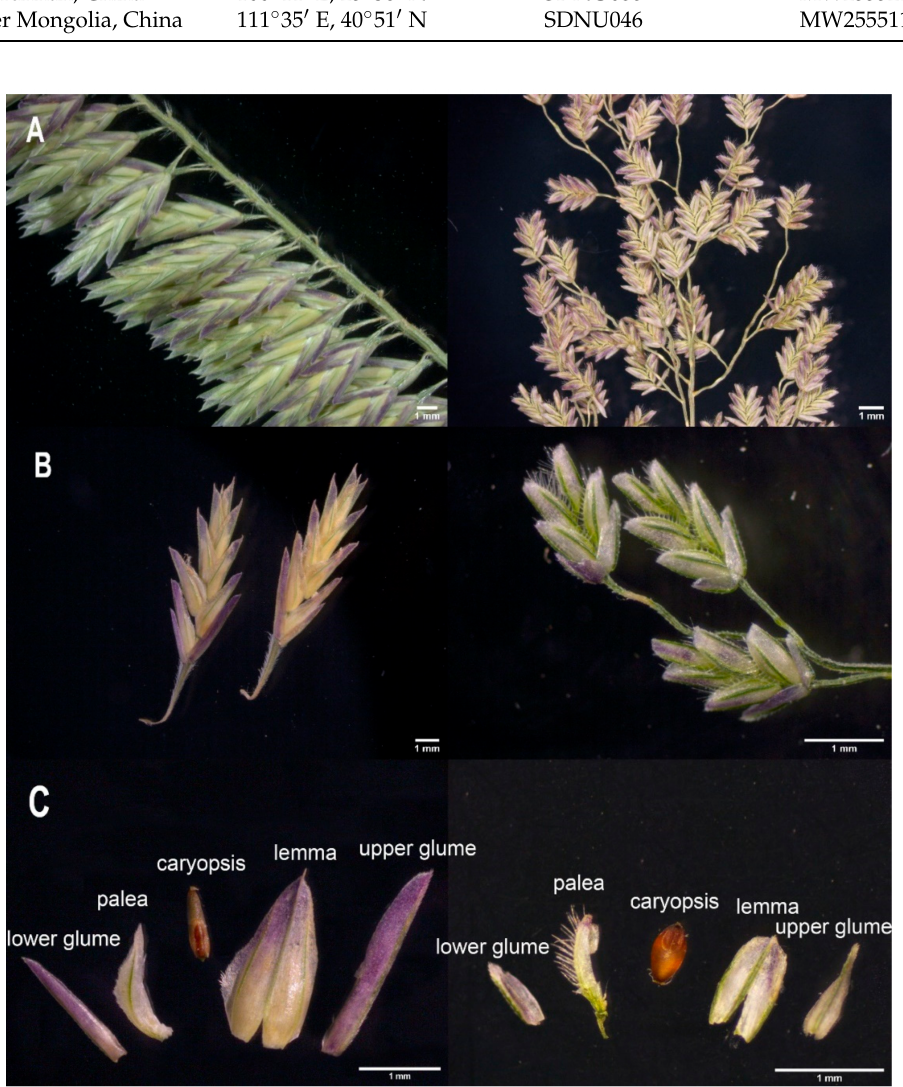
Figure 1. The flower structures of Harpachne harpachnoides (left) and Eragrostis tenella (right). ( A ) Inflorescence structure; ( B ) Spikelets structure; ( C ) Floret